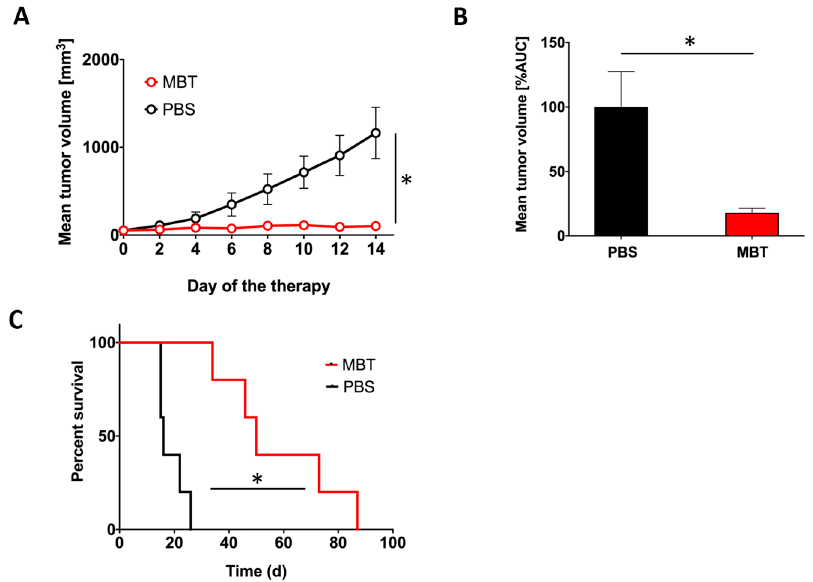
Figure 3. Intratumoral application of MBT in subcutaneous PHEO. B6(Cg)- Tyr c-2J /J mice were subcutaneously injected with MTT-luciferase cells. After tumors grew to the desired size (about 100 mm 3 ), mice were randomized into two groups ( n = 5/group): (i) the group treated with MBT; (ii) the group treated with PBS. MBT and PBS were given intratumorally on days 0, 1, 2, 8, 9, 10, 16, 17, 18, 24, 25, and 26. Tumor volume was measured with a caliper. ( A ) The tumor volume growth is presented as a growth curve (* p < 0.05 against PBS) and ( B ) as an area under the curve (AUC) (* p < 0.05 against PBS). ( C ) The survival analysis for the two groups are presented as a Kaplan–Meier curve (* p < 0.05 against